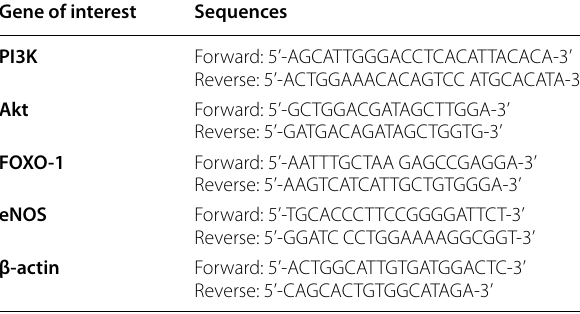
PI3K Phosphatidylinositide 3‑Kinases, AKT Serine and Threonine Kinase, FOXO-1 Forkhead Box Protein O, eNOS Endothelial Nitric Oxide Synthase